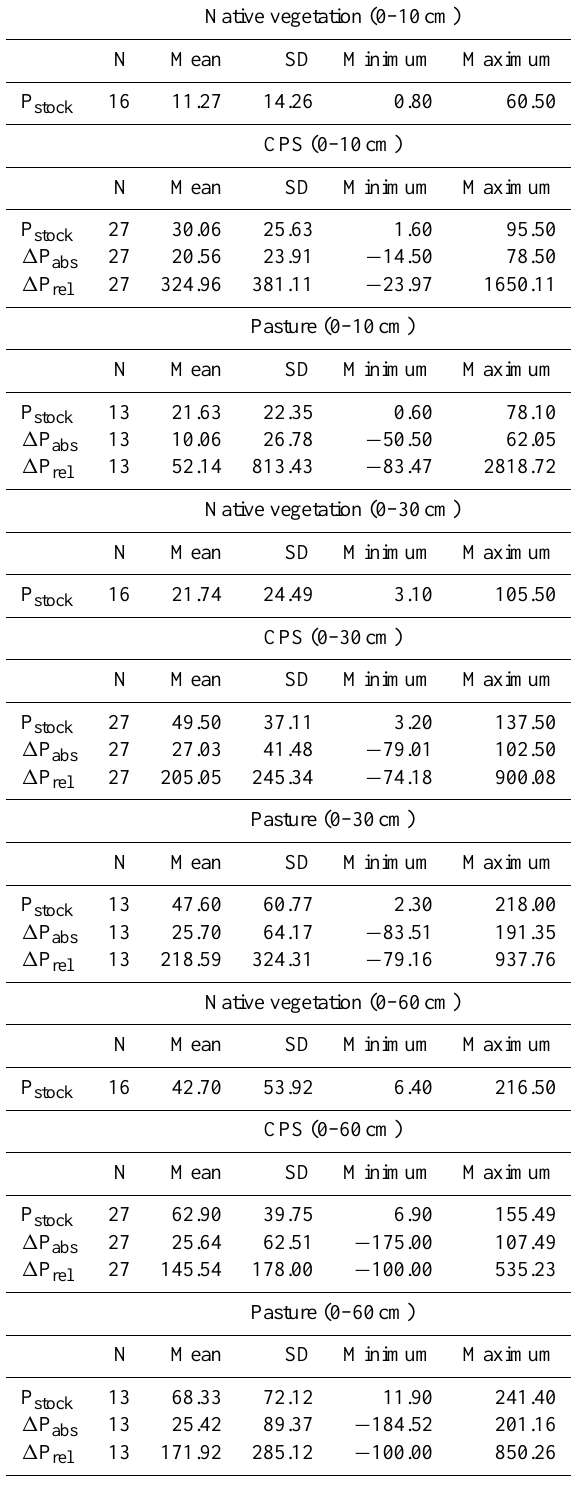
Table 3. Mean, standard deviation (SD), and minimum and maximum of soil phosphorus stocks (P stock , expressed as kgha − 1 ) at 0–10, 0–30, and 0–60cm soil depth layer for forest, crop–livestock systems and pasture soils at the paired study sites. (cid:49) P abs is the difference between the soil phosphorus stock of native vegetation and crop livestock systems and pasture soils obtained in the paired study sites (expressed as kgha − 1 ) . (cid:49) P rel is the same difference expressed as a percentage. Phosphorus losses are indicated by a minus sign ( −